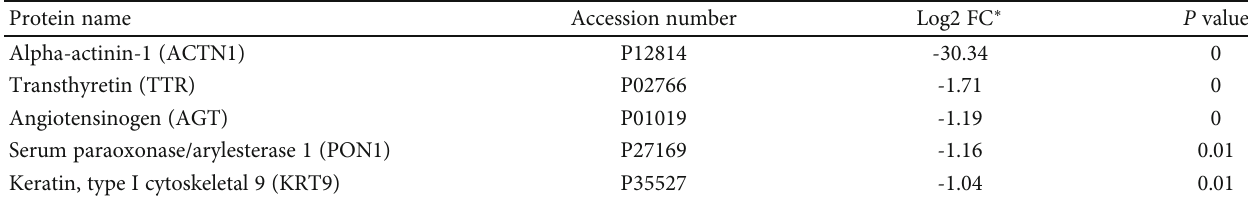
Table 3: The di ff erentially downregulated exosomal proteins in rheumatoid